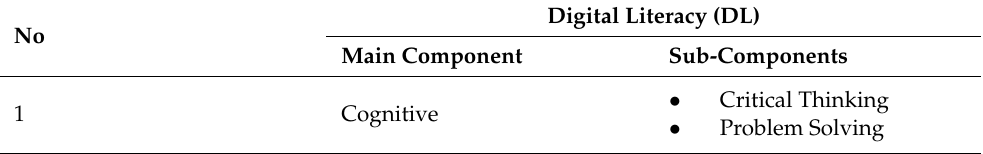
Table 1. Cognitive